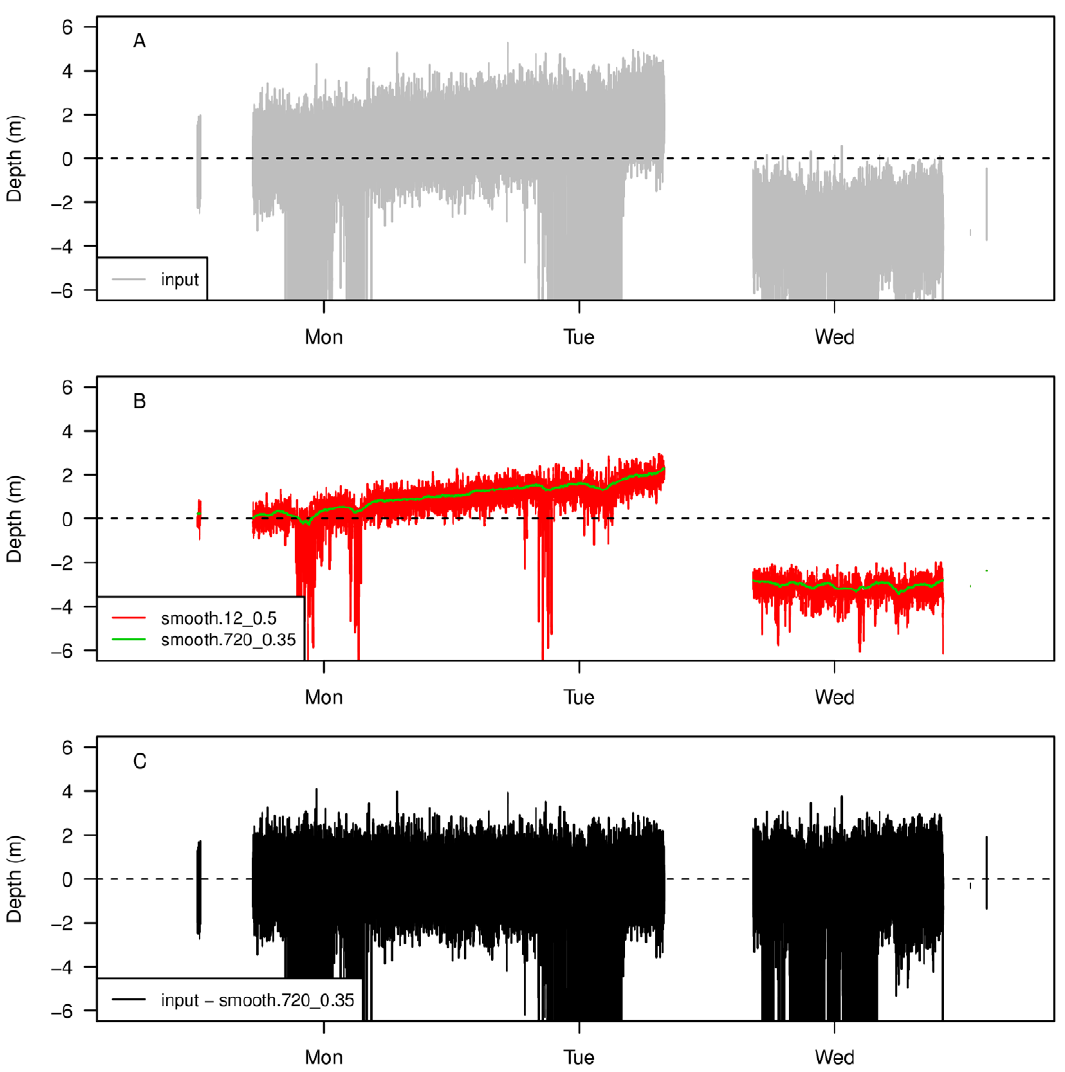
Figure 2. Result of filtering method for zero offset correction of diving depth time series. Corrupted input time series (A), first filter (median) using a moving window of size 12 (1 min) and second filter (0.35 quantile) using moving window of size 720 (1 h) (B), and corrected depth (corrupted series minus last filter) (C). The y-axis limits are restricted to be approximately equal to the range of surface depth in the time series for clarity.